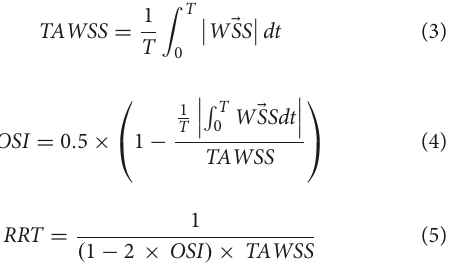
Although the flow rate curve at the mitral valve in all cases is the same, the periodic blood flow velocity boundary